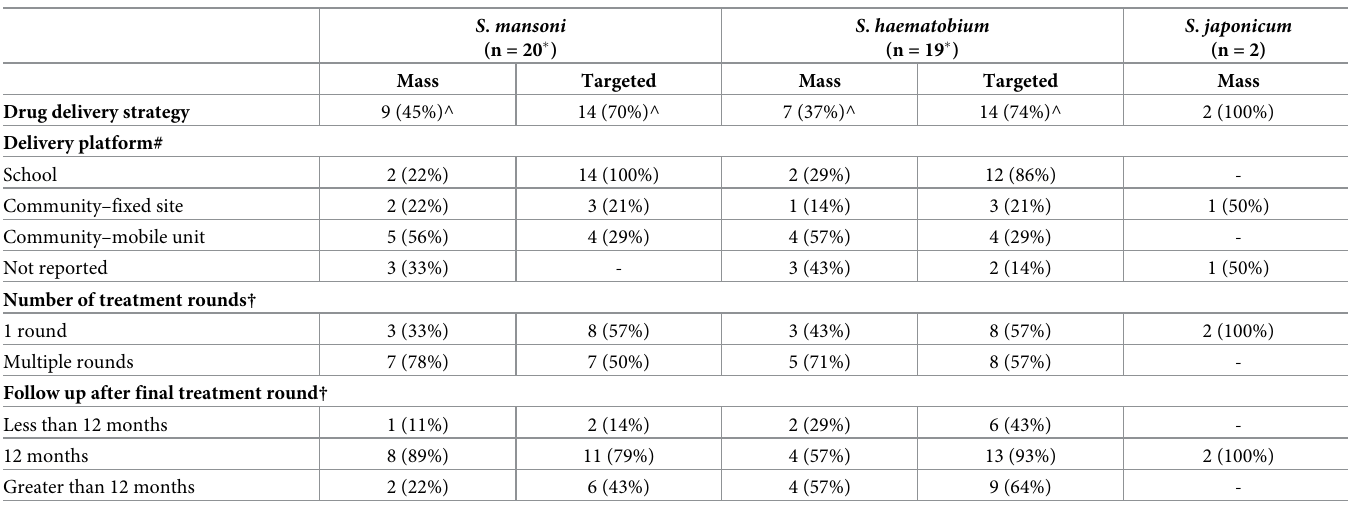
Table 2. Descriptive indicators separated by schistosome